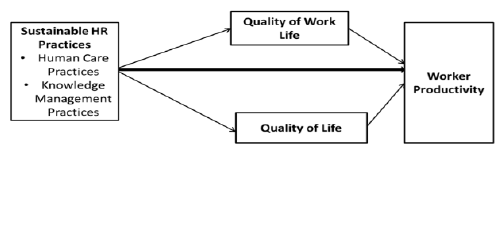
Figure 1. Conceptual